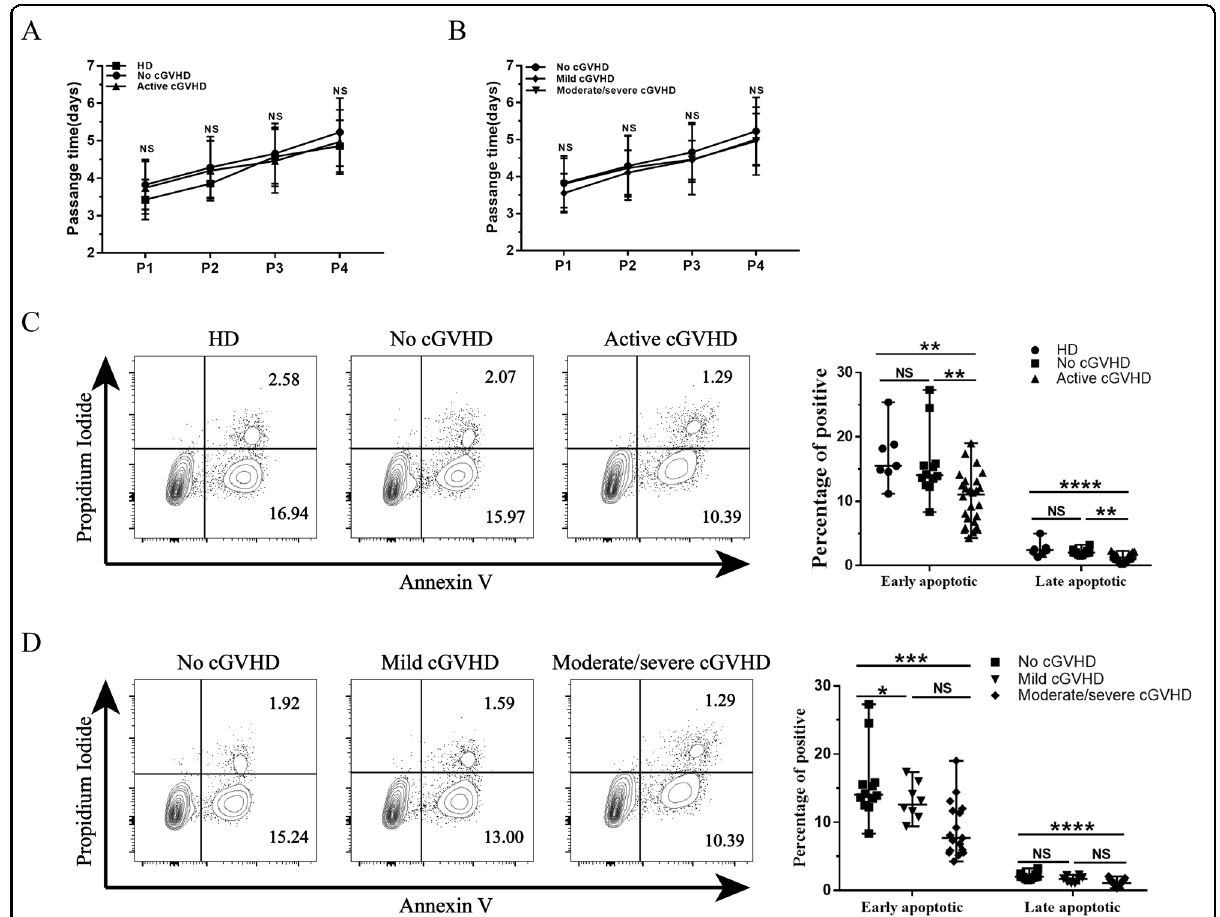
Fig. 2 The proliferation of MSCs was similar in the three groups, while apoptotic cells were decreased in MSCs from patients with active cGVHD. A Passage time of HD-MSCs ( N = 7), no cGVHD-MSCs ( N = 33) and active cGVHD-MSCs ( N = 33) from P1 – P4. B Passage time of MSCs from P1 – P4 with different severities of cGVHD ( N = 8 in mild cGVHD and N = 25 in morderate/severe cGVHD). C Representative apoptosis analysis in MSCs by fl ow cytometry. The percentage of early and late apoptotic cells (median with interquartile range) in HD-MSCs ( N = 7), no cGVHD-MSCs ( N = 12) and active cGVHD-MSCs ( N = 25) were quanti fi ed are shown in histograms. D Representative apoptosis analysis in MSCs with different severity of cGVHD ( N = 8 in mild cGVHD-MSCs and N = 17 in moderated/severe cGVHD-MSCs). Black bars in each fi gure represent the median ± range. NS, not signi fi cant. ** P < 0.01, *** P < 0.001, and **** P <